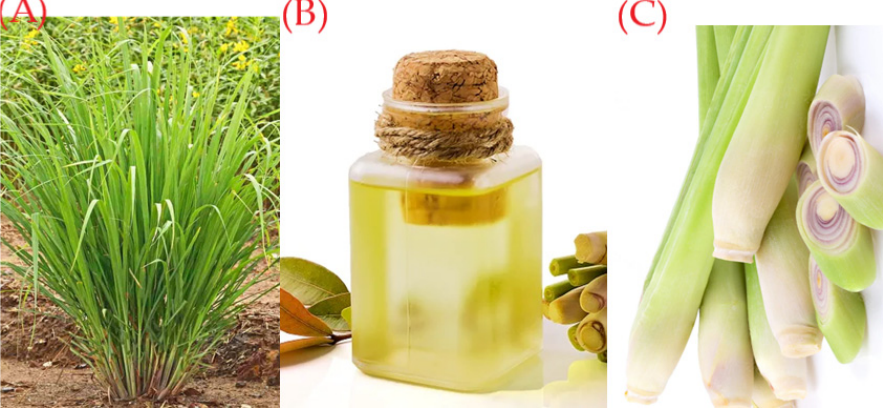
Figure 1. Lemongrass plant ( A ), lemongrass oil ( B ), and lemongrass stalks ( C ).